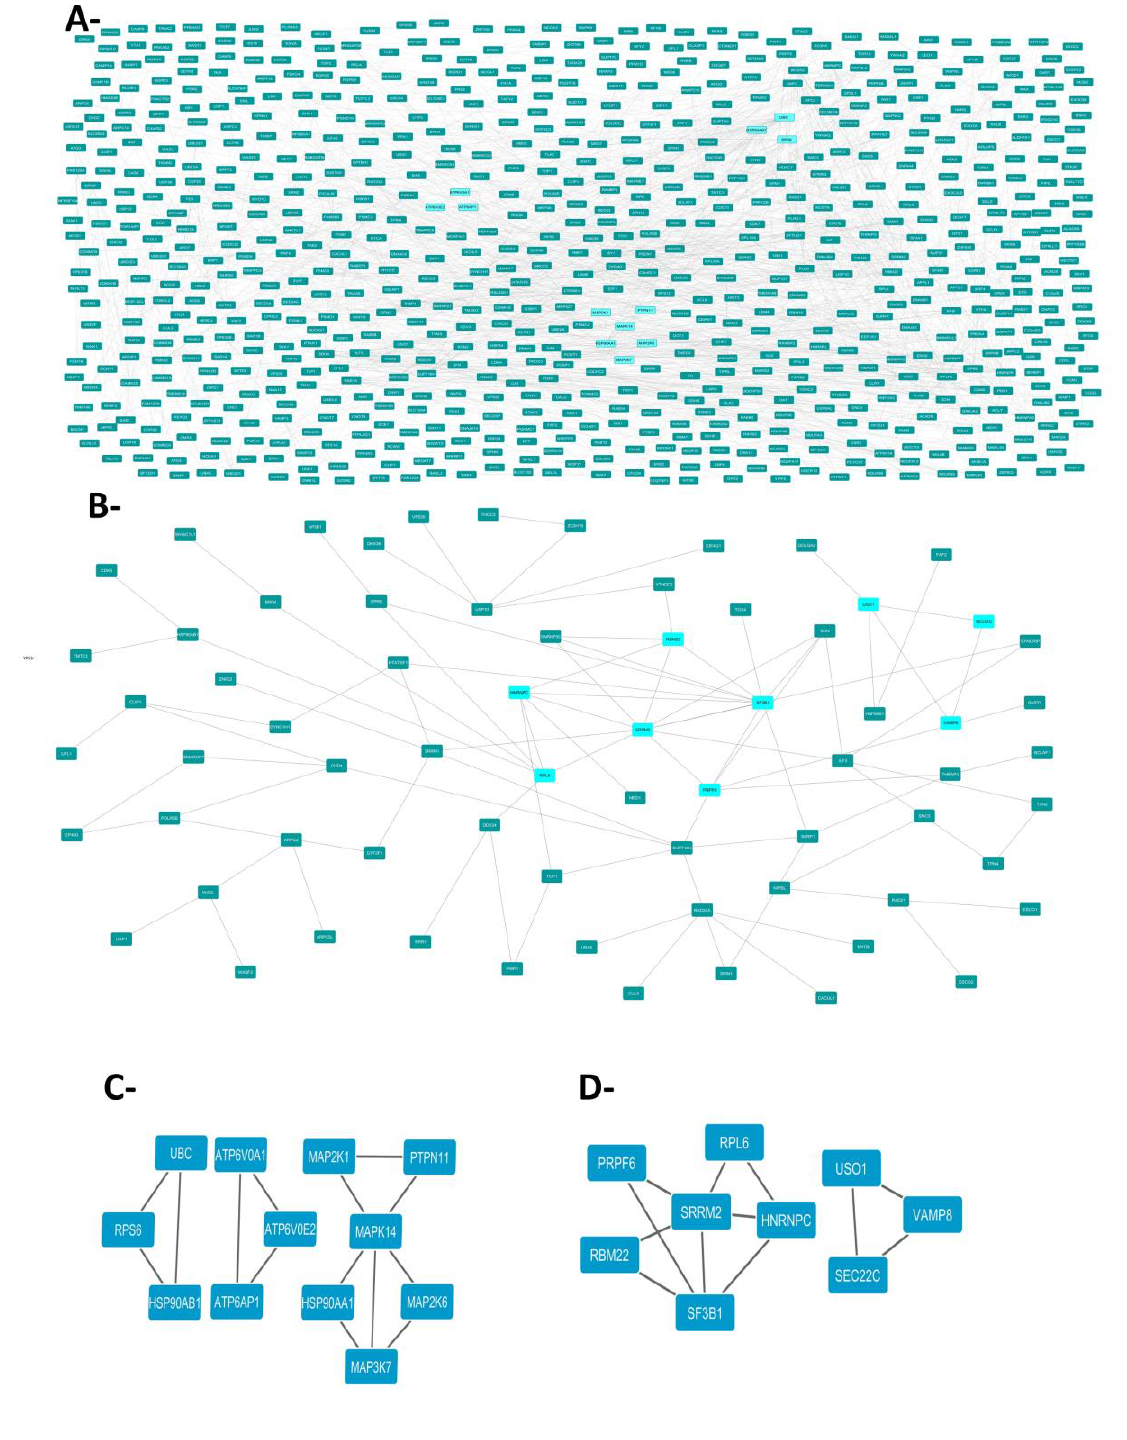
Fig. 3 . Conserved experimentally validated STRING networks and the explored top-ranked motifs for TP53 - and TP53 + gastric cancer subtypes: A) STRING conserved experimentally validated network for the genes present in the TP53 - subtype brown module; B) STRING conserved experimentally validated network for the genes present in the TP53 + subtype green-yellow module; Explored top-ranked motifs in the STRING networks highlighted with turquoise color nodes (A and B); The explored motifs from the STRING networks represented separately for TP53 - and TP53 + subtypes in panel C and D